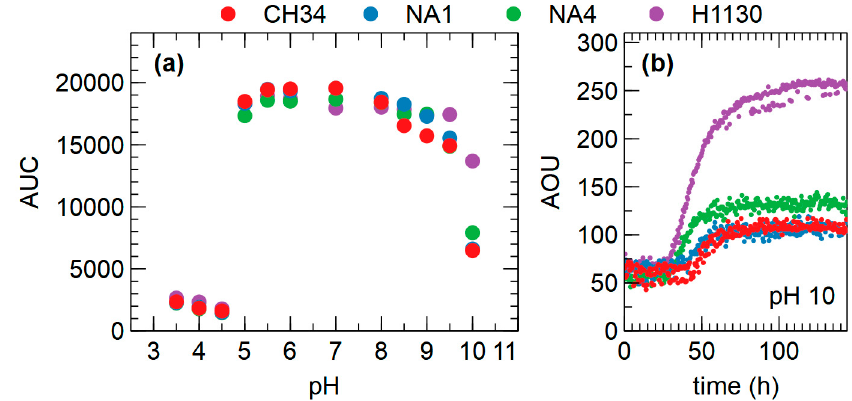
Figure 13. ( a ) Overview of OmniLog phenotypic assays related to pH (AUC = area under the curve) for C. metallidurans CH34, NA1, NA4 and H1130, ( b ) Growth kinetics at pH 10 (AOU = arbitrary OmniLog units).